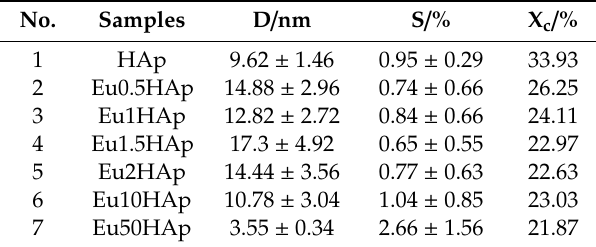
Table 1. Calculated crystallite size ( D ) values and degree of crystallinity (X c ) of pure HAp and europium doped hydroxylapatite with various amount of Eu.